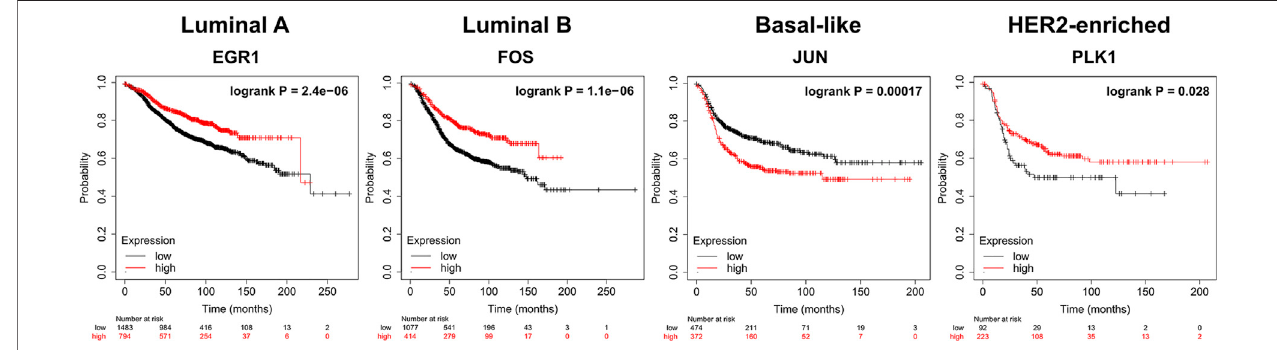
FIGURE 6 | Survival analysis (Kaplan-Meier plots) of dysregulated biomarkers. biomarkers High values are shown in red and low values are shown in